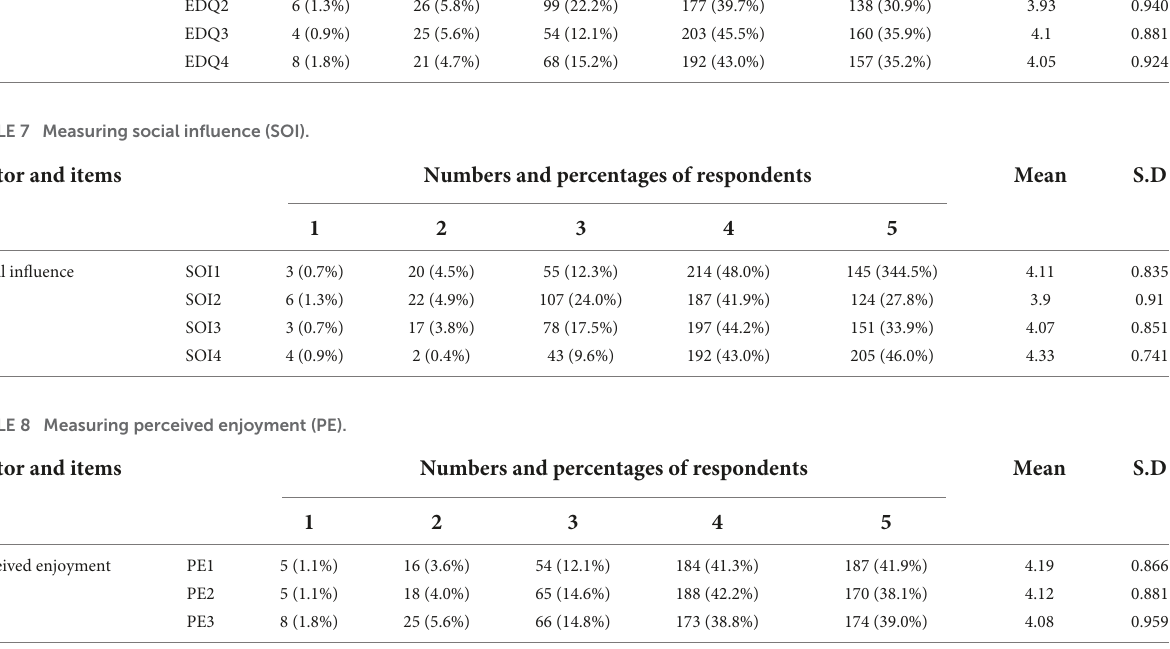
TABLE 9 Measuring perceived ease of use